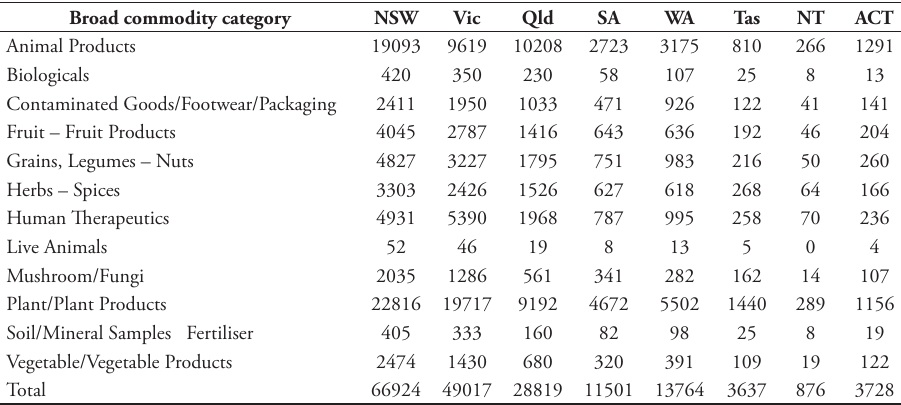
Table 3. Counts of seizures from 2008–2011 by broad commodity category and state/territory. Broad commodity category